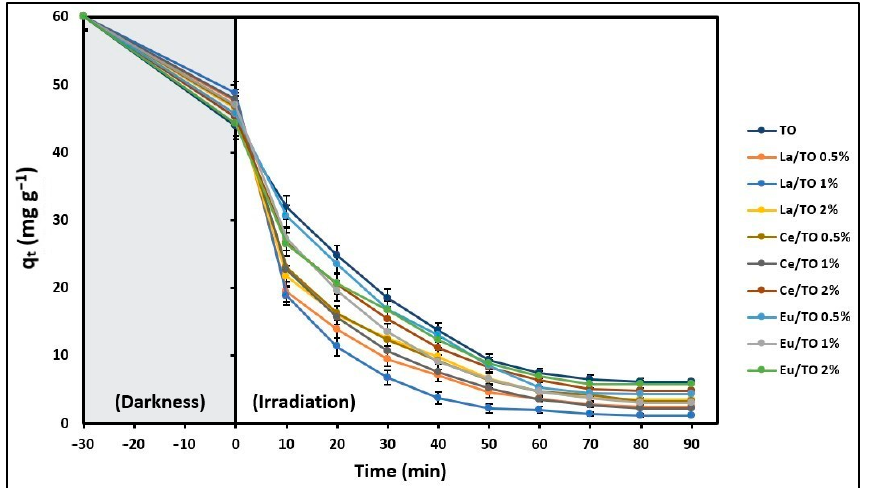
Figure 5 . Cyanide removal capacity as a function of nanoparticles composition (catalyst concentra- tion = 0.2 g L − 1 ; cyanide concentration = 20 mg L − 1 ; solution pH = 7.0 ± 0.1) .